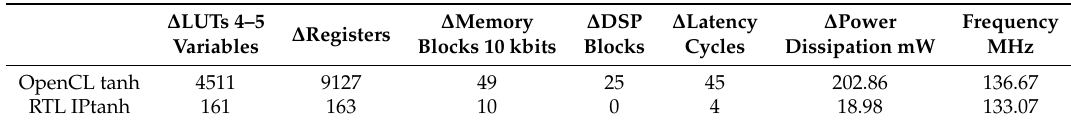
Table 1. Comparison between tanh